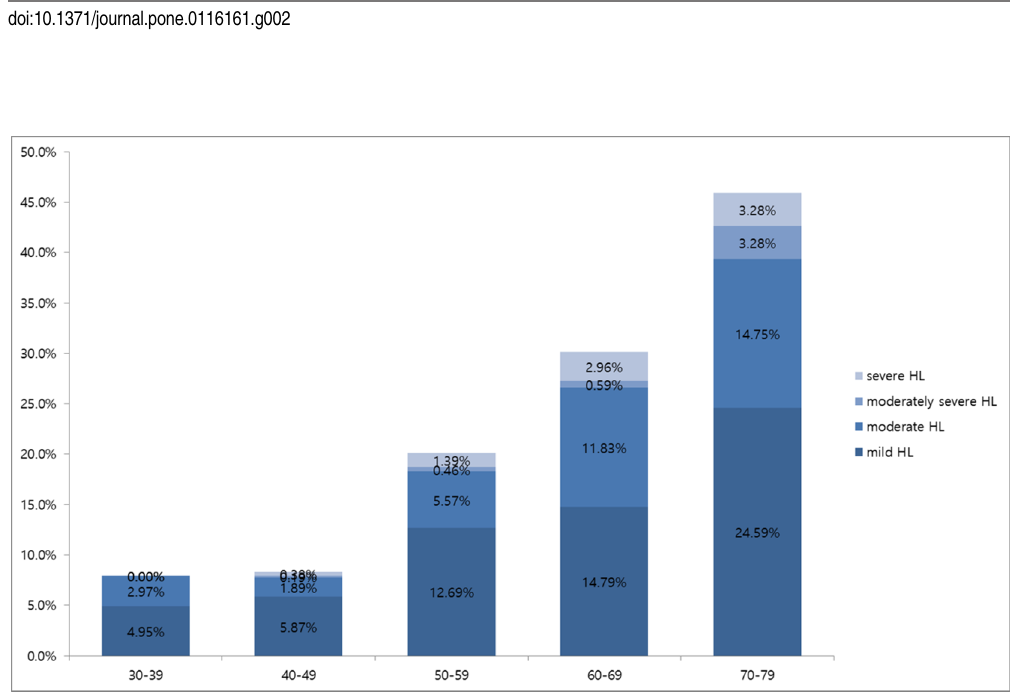
Fig. 3. Prevalence of hearing loss according to the severity of hearing loss by age group in patients with DM.